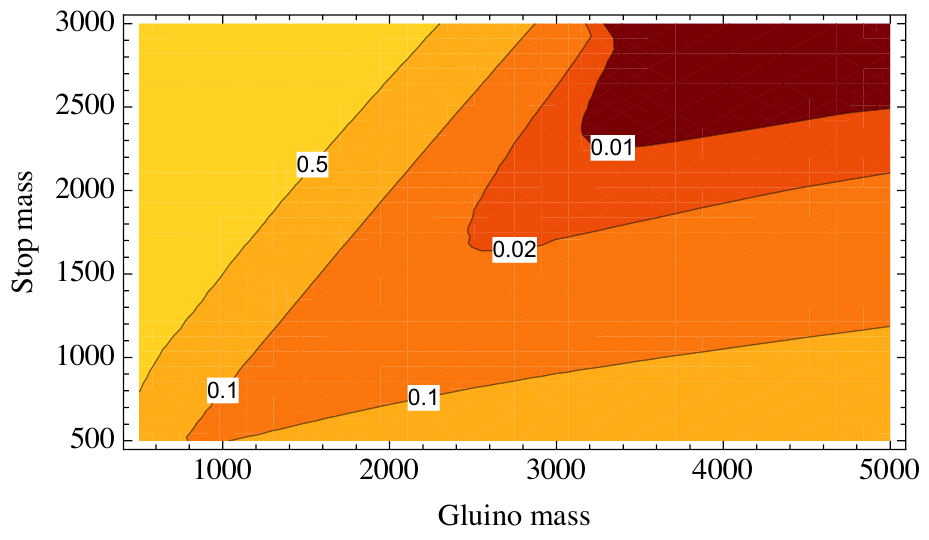
Figure 1 . Ratio of the 13 TeV total cross section for gluino, squark, and antisquark pair production (in all combinations) in the E(cid:11)ective SUSY model compared to the vanilla SUSY cross section, as a function of gluino and stop